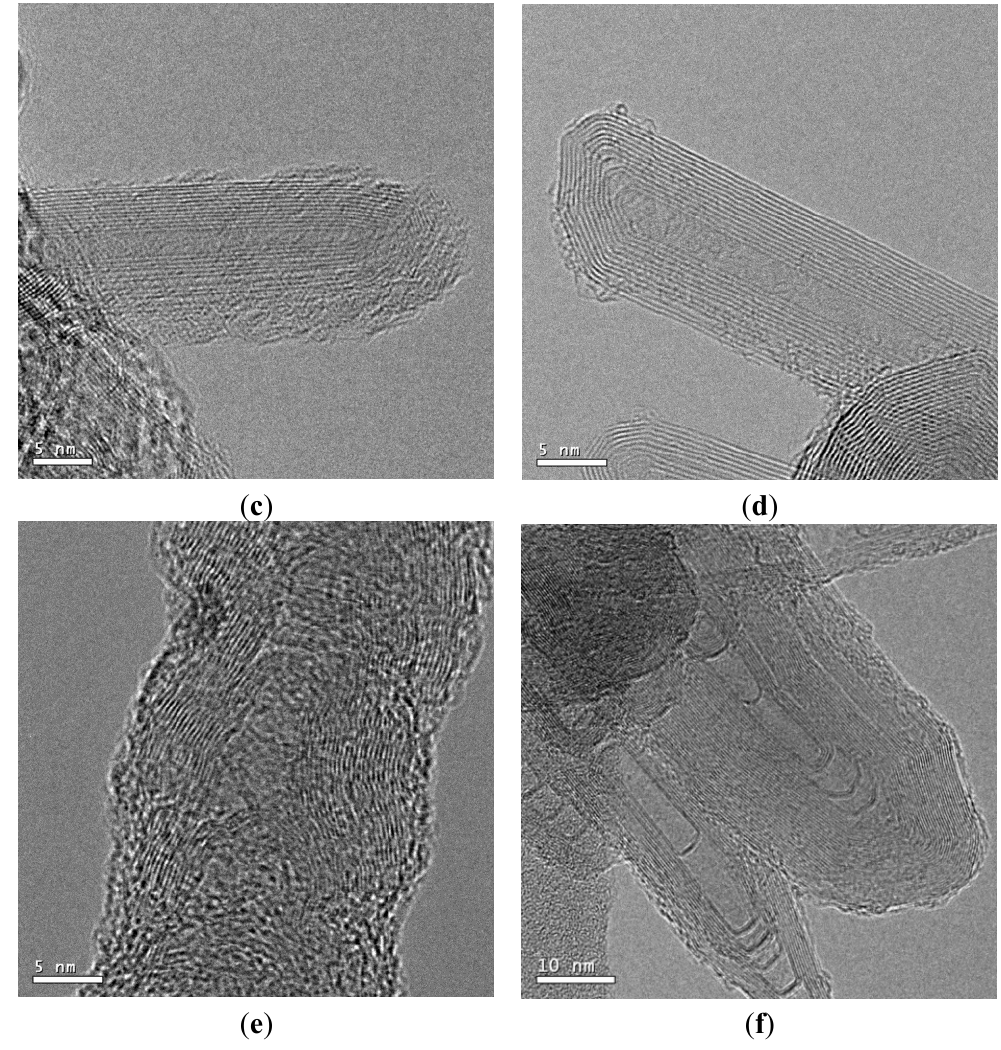
Figure 6. TEM images of carbon nanomaterials synthesized at z = 10 mm for f values of